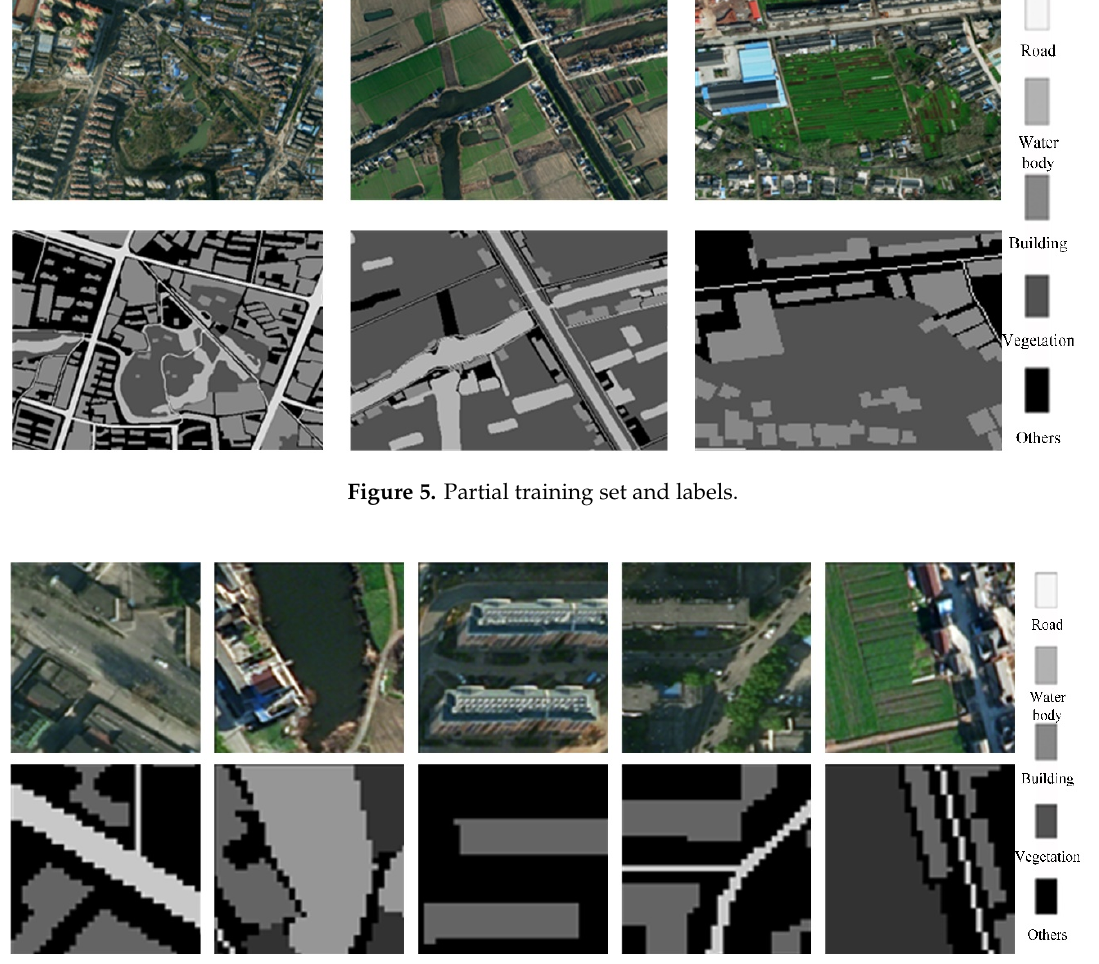
Figure 7. Data augmentation examples. 4.2.2. Data equalization